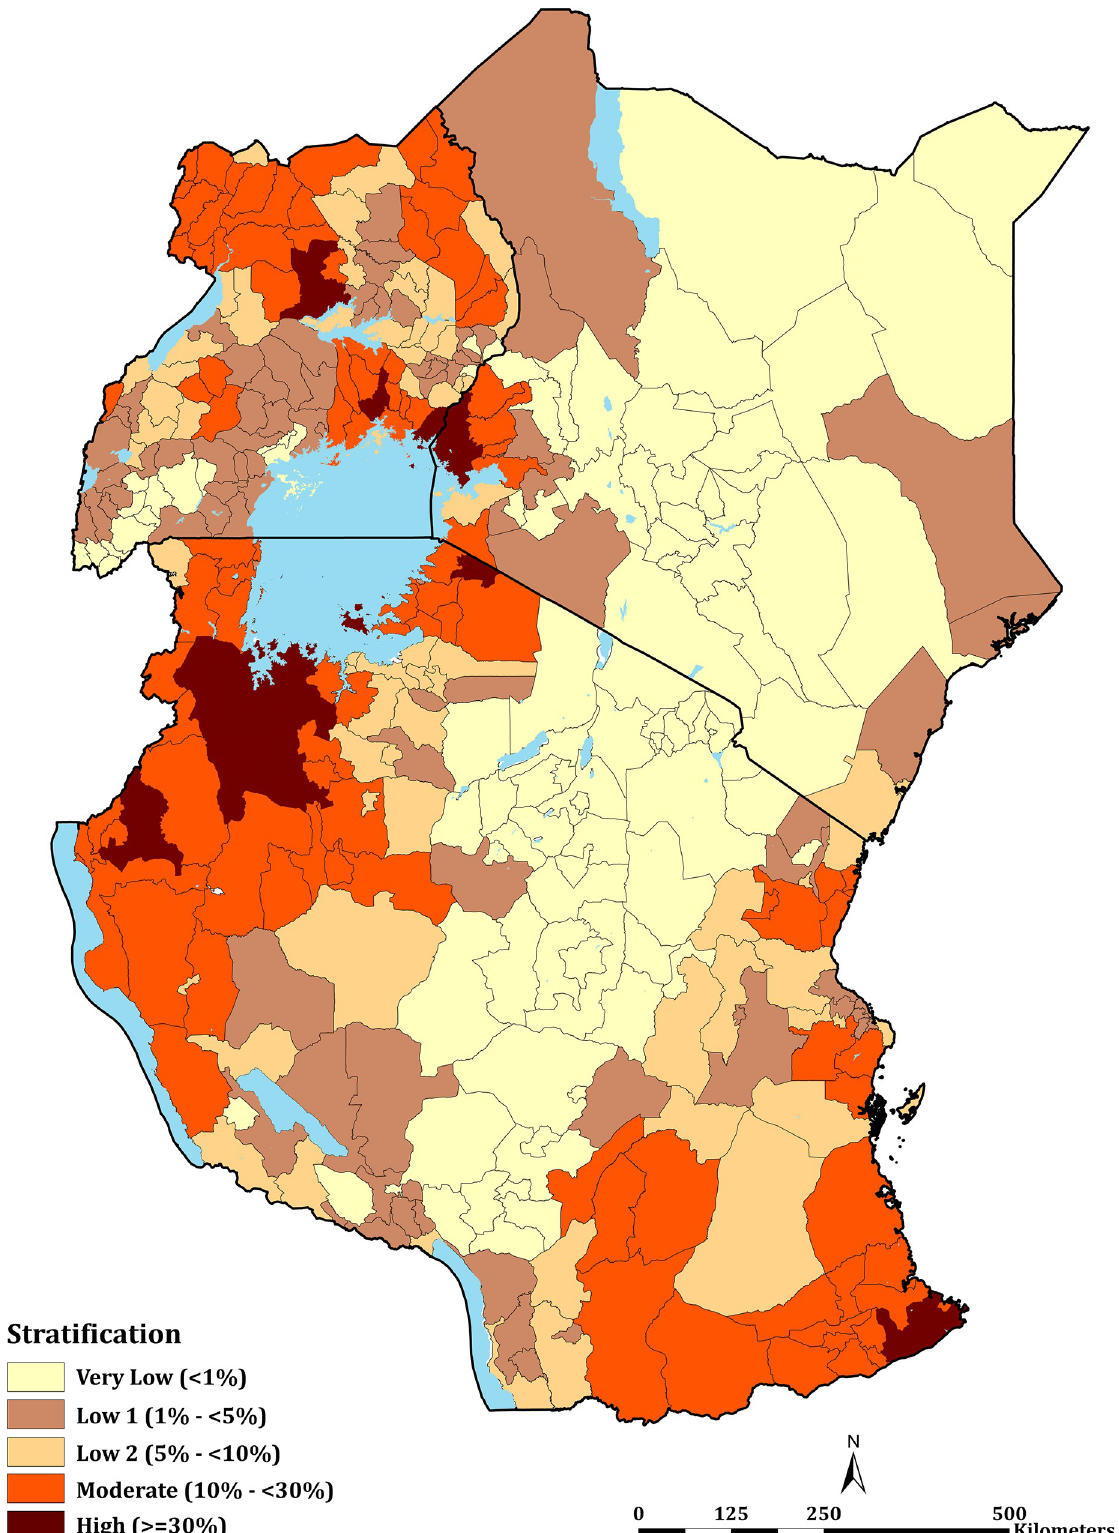
Fig 4. East Africa Pf PR 2-10 stratification. Stratification of health decision-making units based on the level of PA Pf PR 2-10 (aggregated mean) for 2020. These comprised 47 counties in Kenya, 184 councils in mainland Tanzania, and 135 districts in Uganda (see S1 Table).